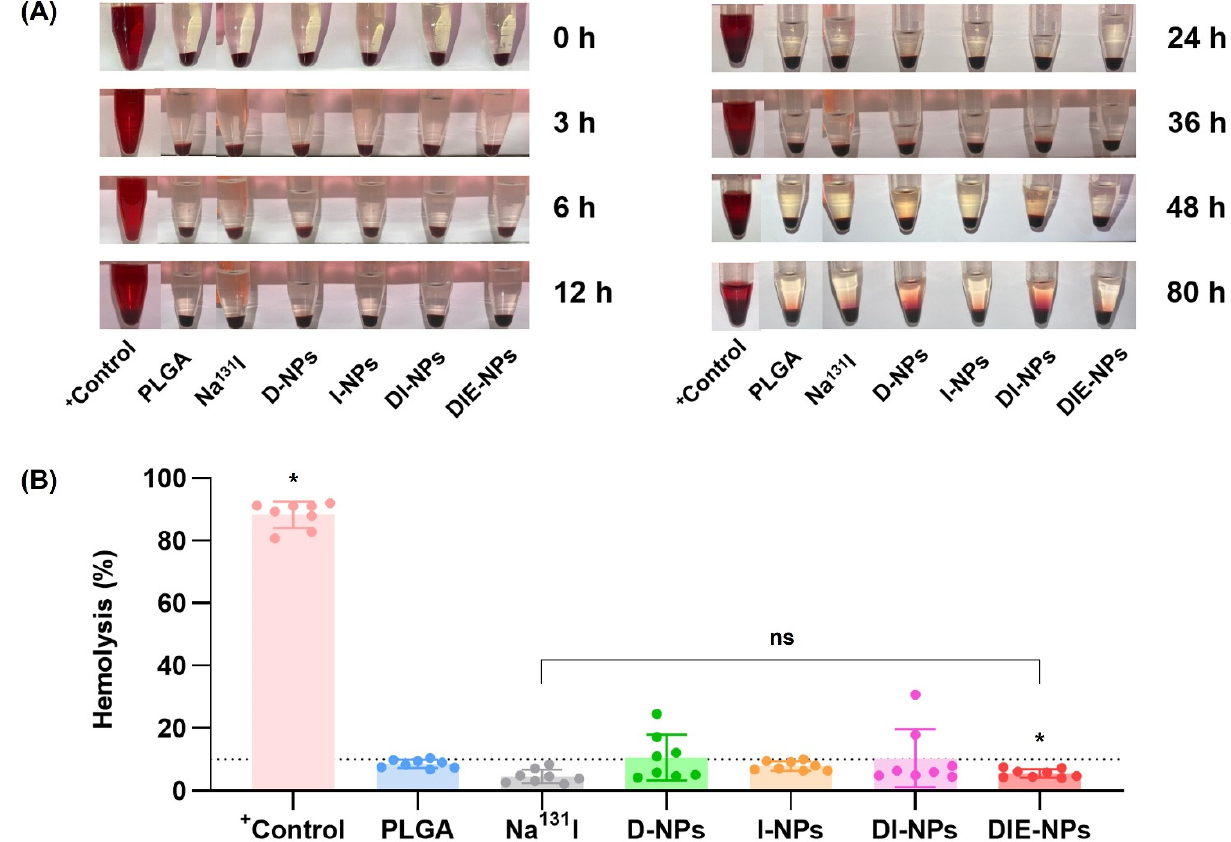
Figure 12. Nanoparticle in vitro hemolytic properties analysis: 8 × 10 9 red blood cells/mL incubated at 37 ◦ C. ( A ) Analysis of red blood cell pellets and the supernatant analysis for lysed hemoglobin; DMSO (positive control), PLGA, Na 131 I, D-NPs, I-NPs, DI-NPs and DIE-NPs after 0, 3, 6, 12, 24, 36, 48, and 80 h incubation. ( B ) Quantitative hemolysis percentage of the supernatant analysis for lysed hemoglobin; DMSO (positive control), PLGA, Na 131 I, D-NPs, I-NPs, DI-NPs after 0, 3, 6, 12, 24, 36, 48, and 80 h incubation. ns = no statistically significant difference in the hemolytic properties between Na 131 I and DIE-NPs ( p > 0.05). * denotes significance in the hemolytic properties between DMSO (positive control) and DIE-NPs ( p < 0.05). Data are given as mean ± standard deviation ( n = 3).